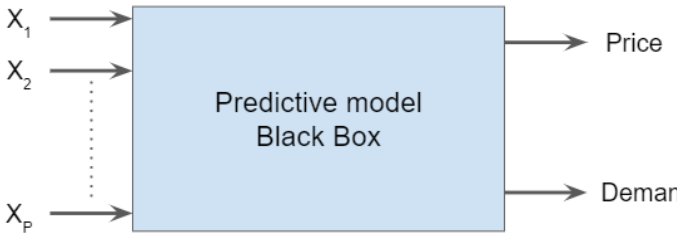
Figure 1. Predictive model. Here, [price, demand] = f( X 1 , X 2 ,..., X p ). Explanatory variables: calendar effects, lagged prices and energy production